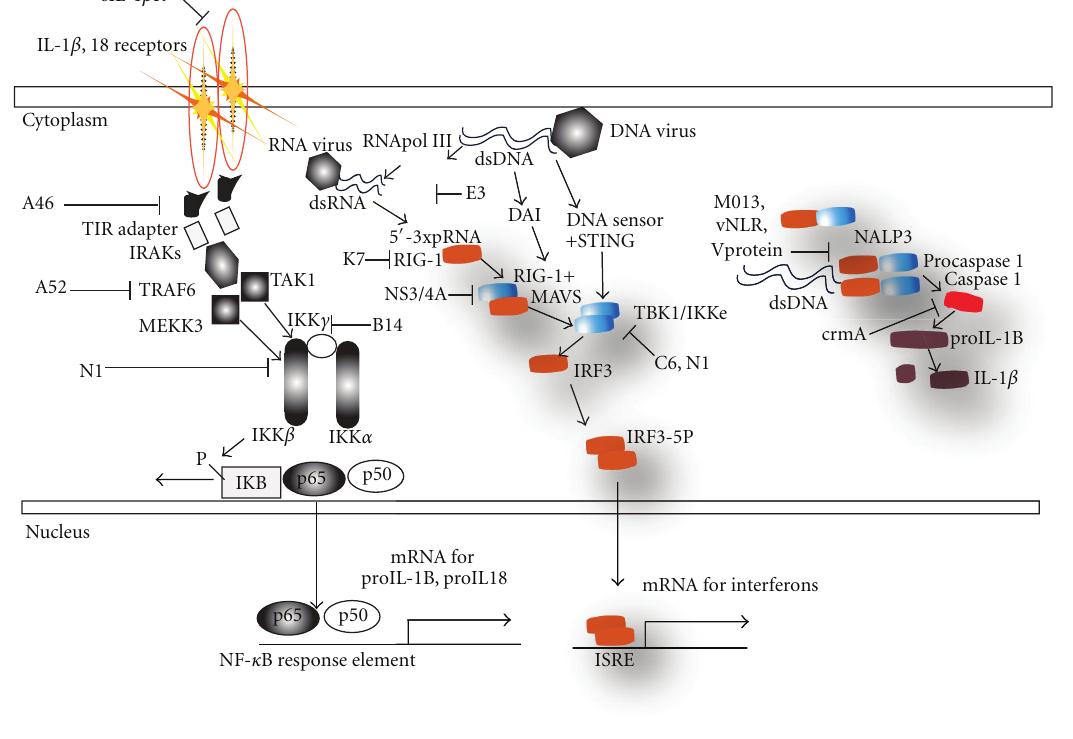
Figure 2: Viral proteins inhibit nucleic acid receptors of the intracytosolic innate immune response. Viruses inhibit each of the two signals that initiate the inflammasome activation process. The first signal—IL-1 β and/or IL-18 binding and activation of the TLR/IL-1 β receptor pathway—is inhibited by soluble IL-1 β and IL-18 (from VACV); downstream, inhibitors of signaling to NF- κ B (from VACV or HCV) repeatedly target this important antiviral pathway that optimally requires NF- κ B translocation leading to the production of pro-IL-1 β and pro-IL-18. Second, the inflammasome processes these pro-IL-1 β and pro-IL-18 proteins via caspase-1 that is itself processed upon clustering mediated at the NLRP3 inflammasome upon detection of intracytosolic pathogens. This leads to IL-1 β and IL-18 production and release that activates the IL-1 β /IL-18 pathway in an autocrine manner, as well as the innate and adaptive immune response. Inflammasome activation is inhibited by myxoma virus M013, measles viruses V protein, and KSHV vNLR. Finally signaling to IRF3 by intracytosolic DNA or RNA is inhibited at the level of MAVS by HCV’s NS3/4A and at the level of TBK1 by VACV C6 and N1 (Figure